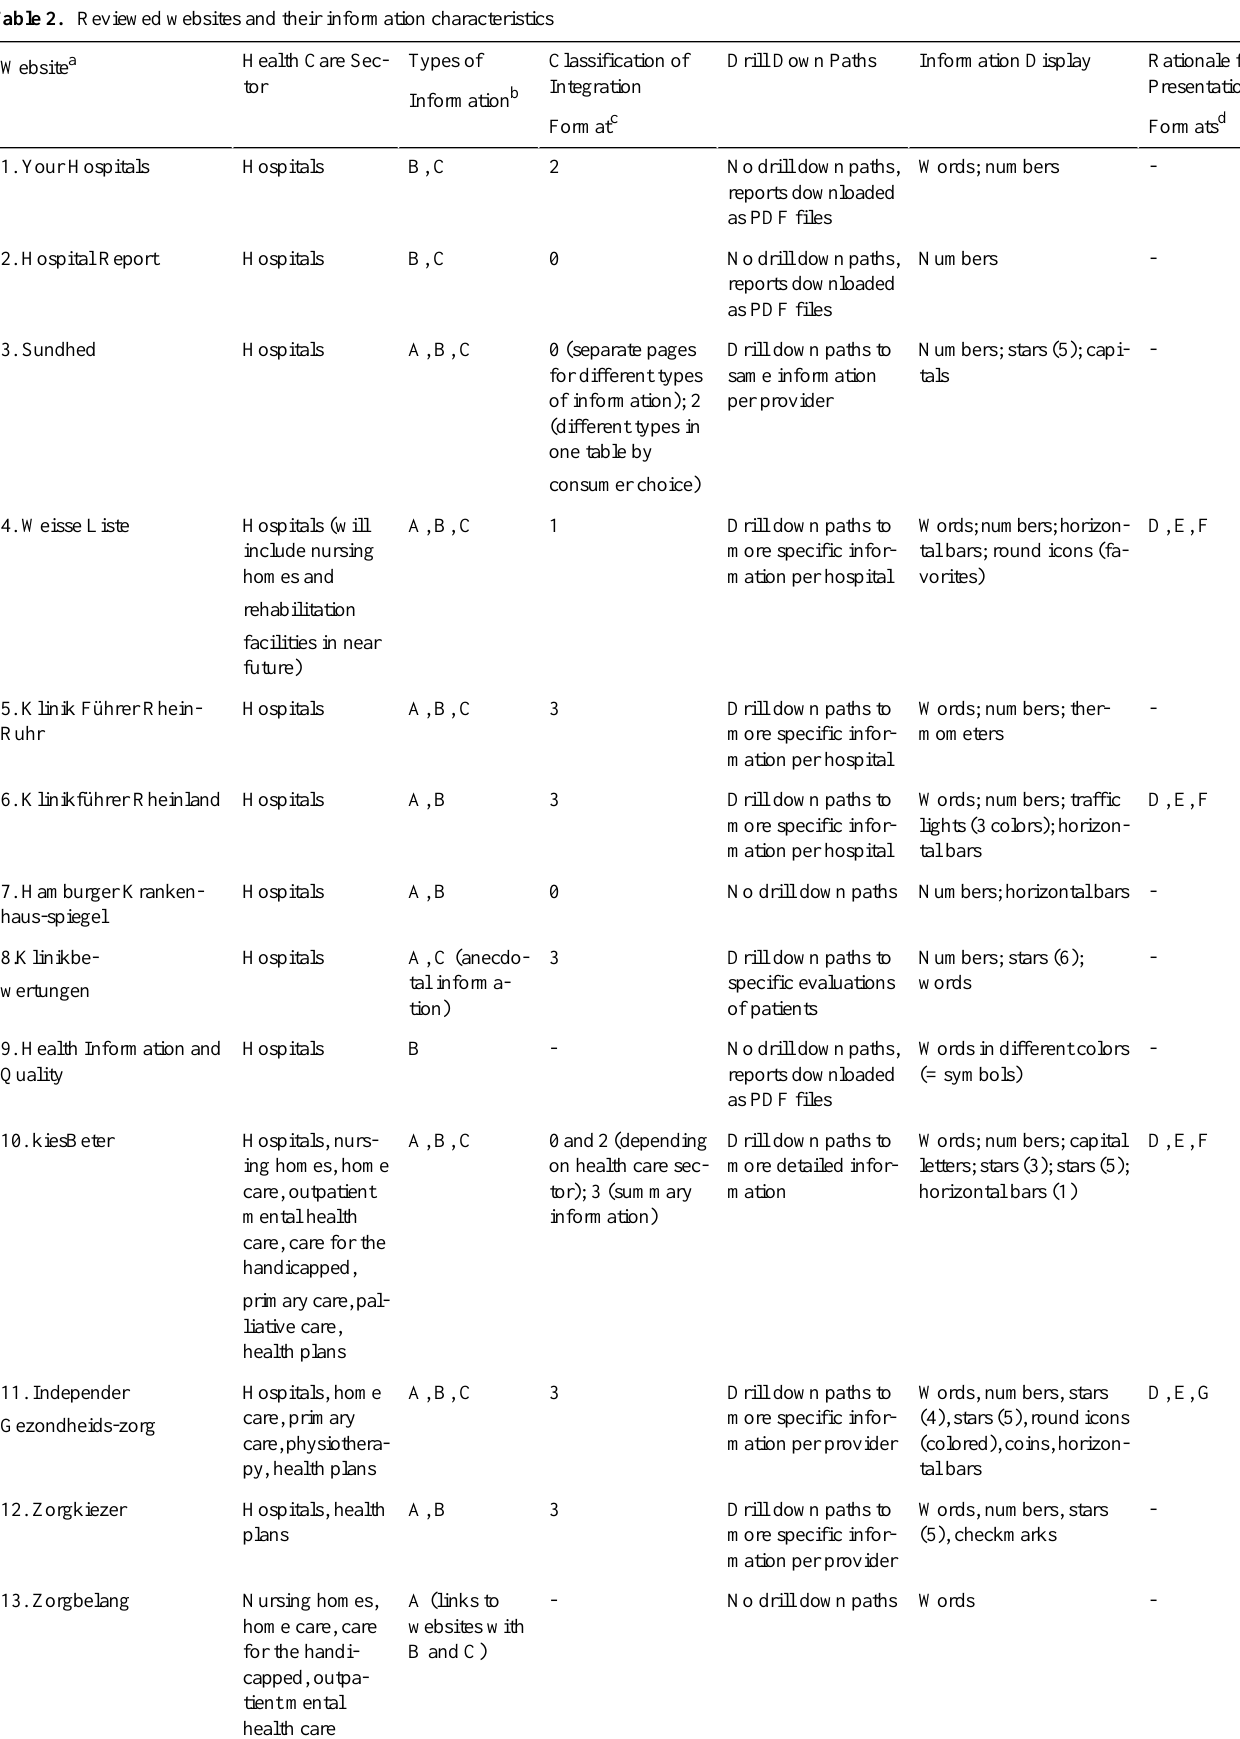
Table 2. Reviewed websites and their information